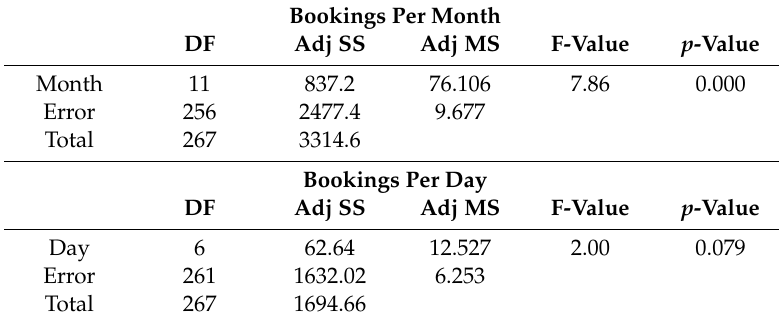
Table 2. One-way ANOVA results. (DF = Degree of Freedom; Adj SS = Adjusted sums of squares;